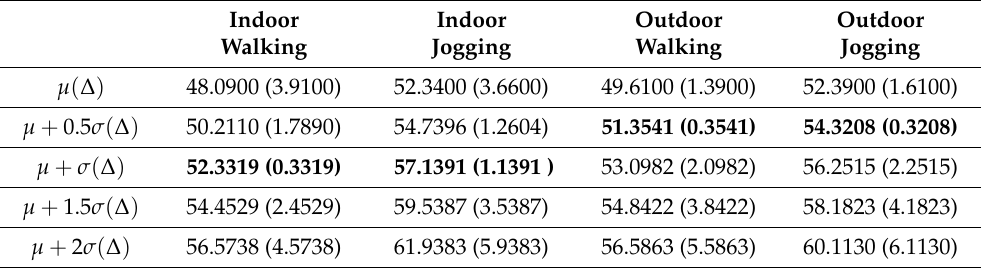
Table 6. Absolute difference ∆ (dB) between the function µ + k σ and the empirical upper threshold (indoor walking: 52 dB; indoor jogging: 56 dB; outdoor walking: 51 dB; outdoor jogging: 54 dB).